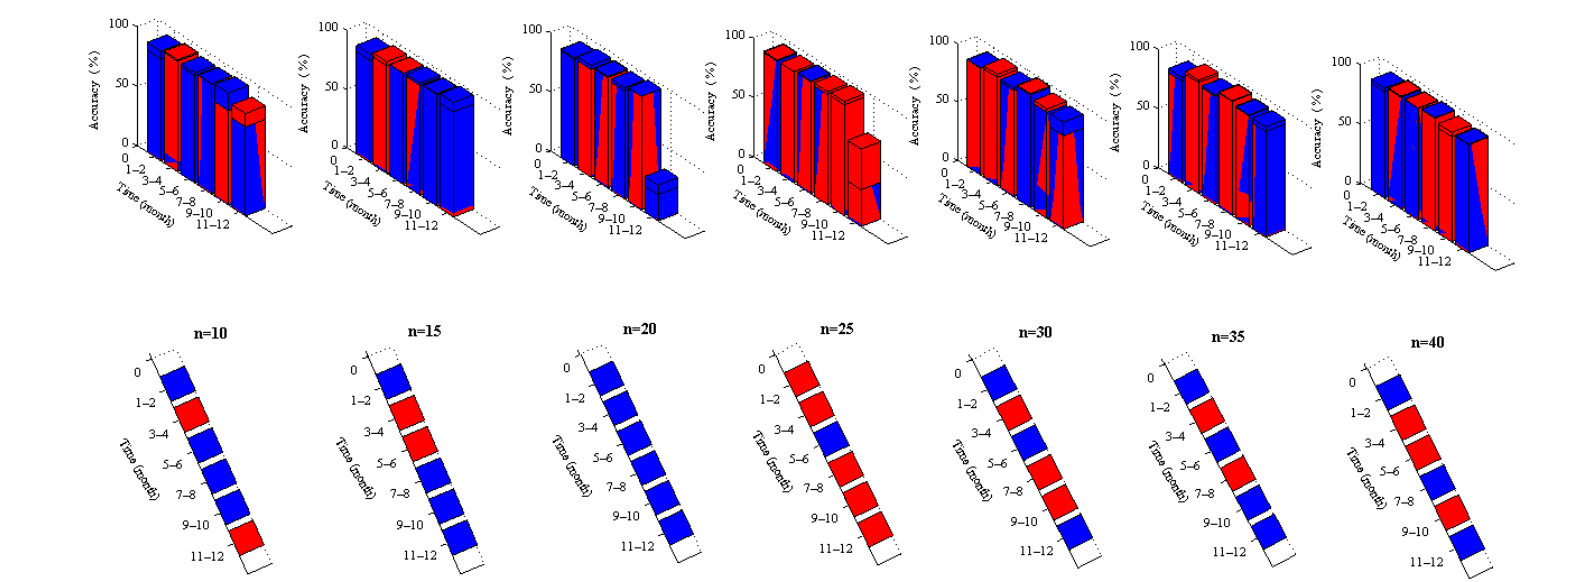
Figure 9. Comparison of prediction accuracy between models with different time windows and the annual model.